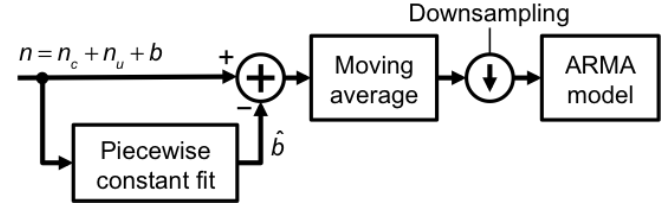
Figure 3. Pressure altitude noise pre-processing (modeling